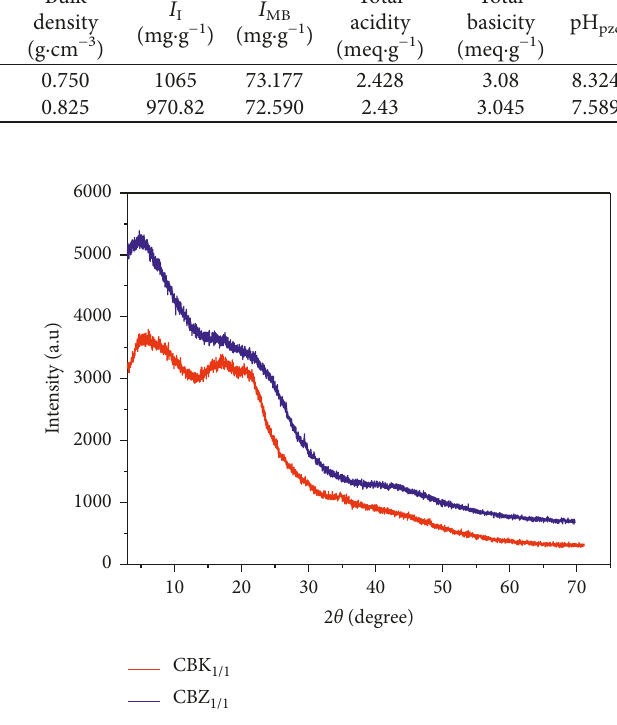
1/1 and CBZ 1/1 ) Figure 4: XRD of activated carbons: CBK